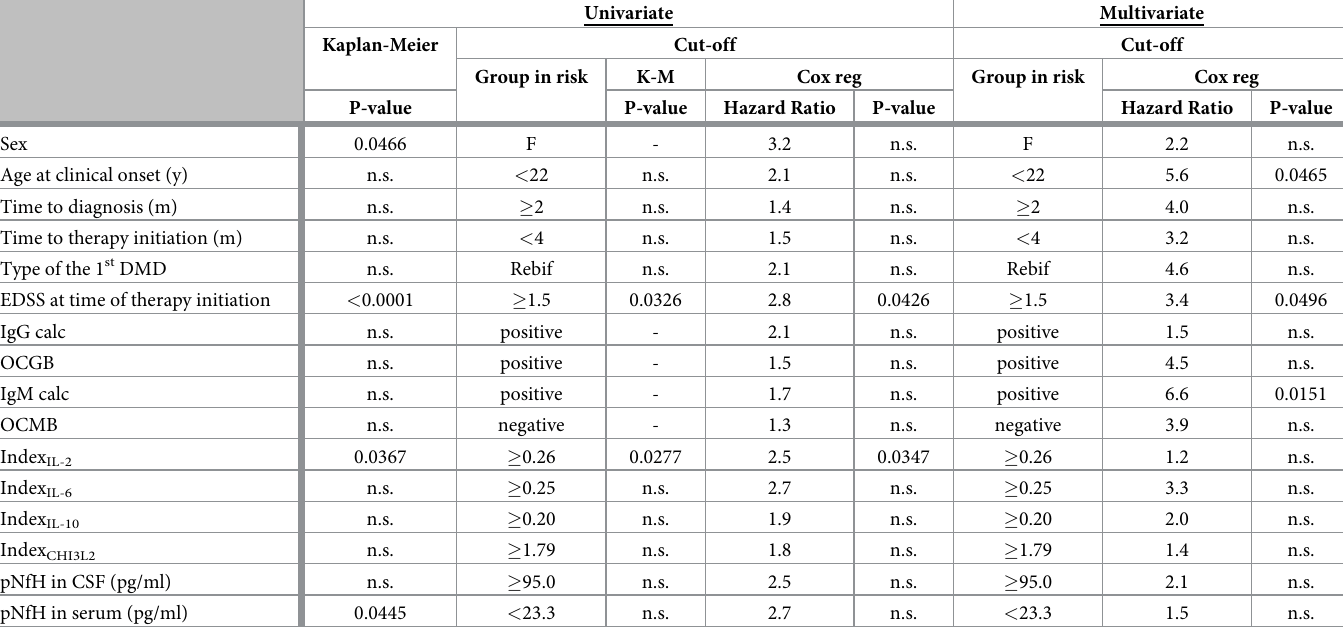
Table 2. Relapse free interval a